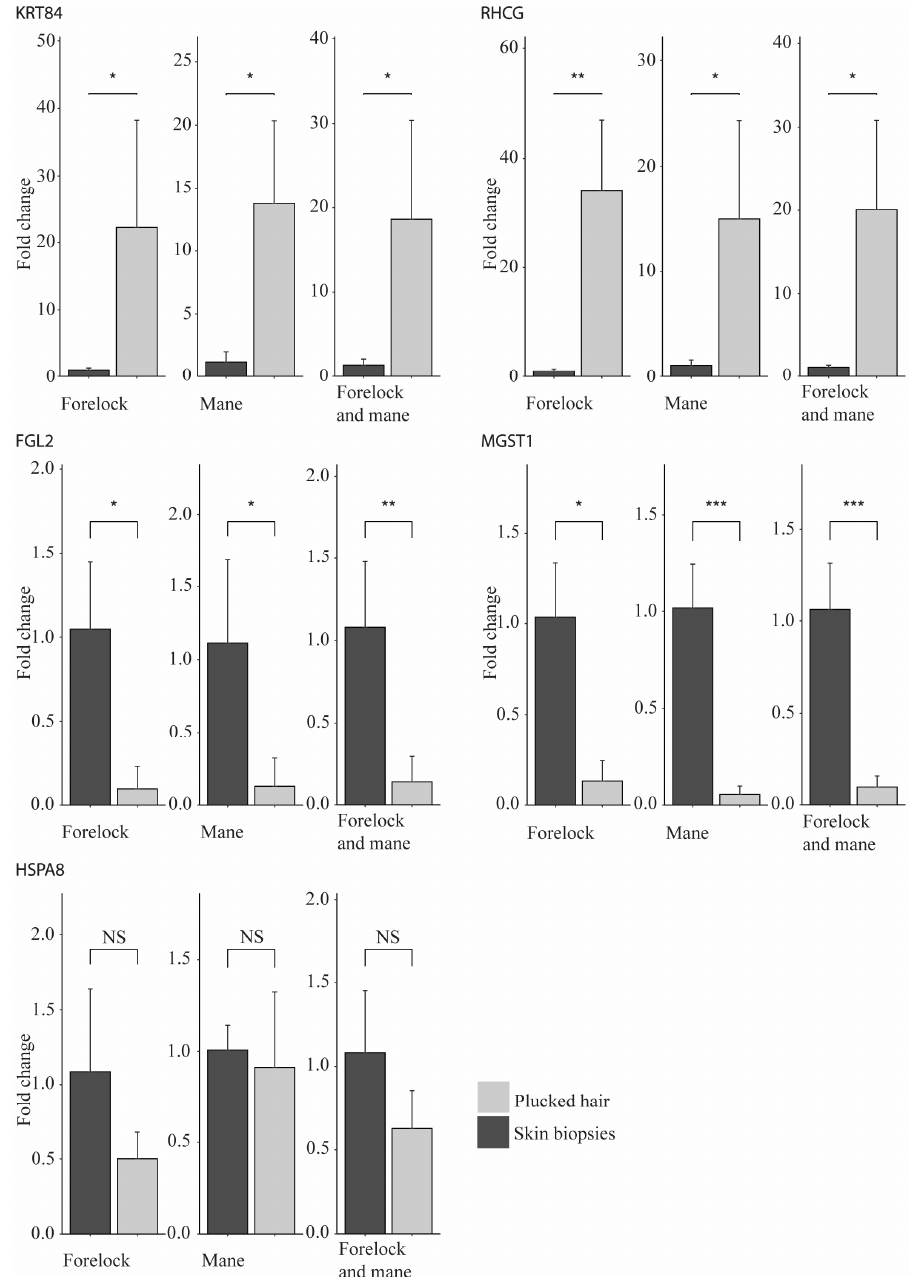
Figure 2. Barplots showing the qPCR results of four upregulated genes in the RNA-seq experiment, plus one control gene. Two-tailed Student’s t -test was used ( n = 7) to calculate p -values. NS: Non- significant, * p < 0.05, ** p < 0.01, *** p <